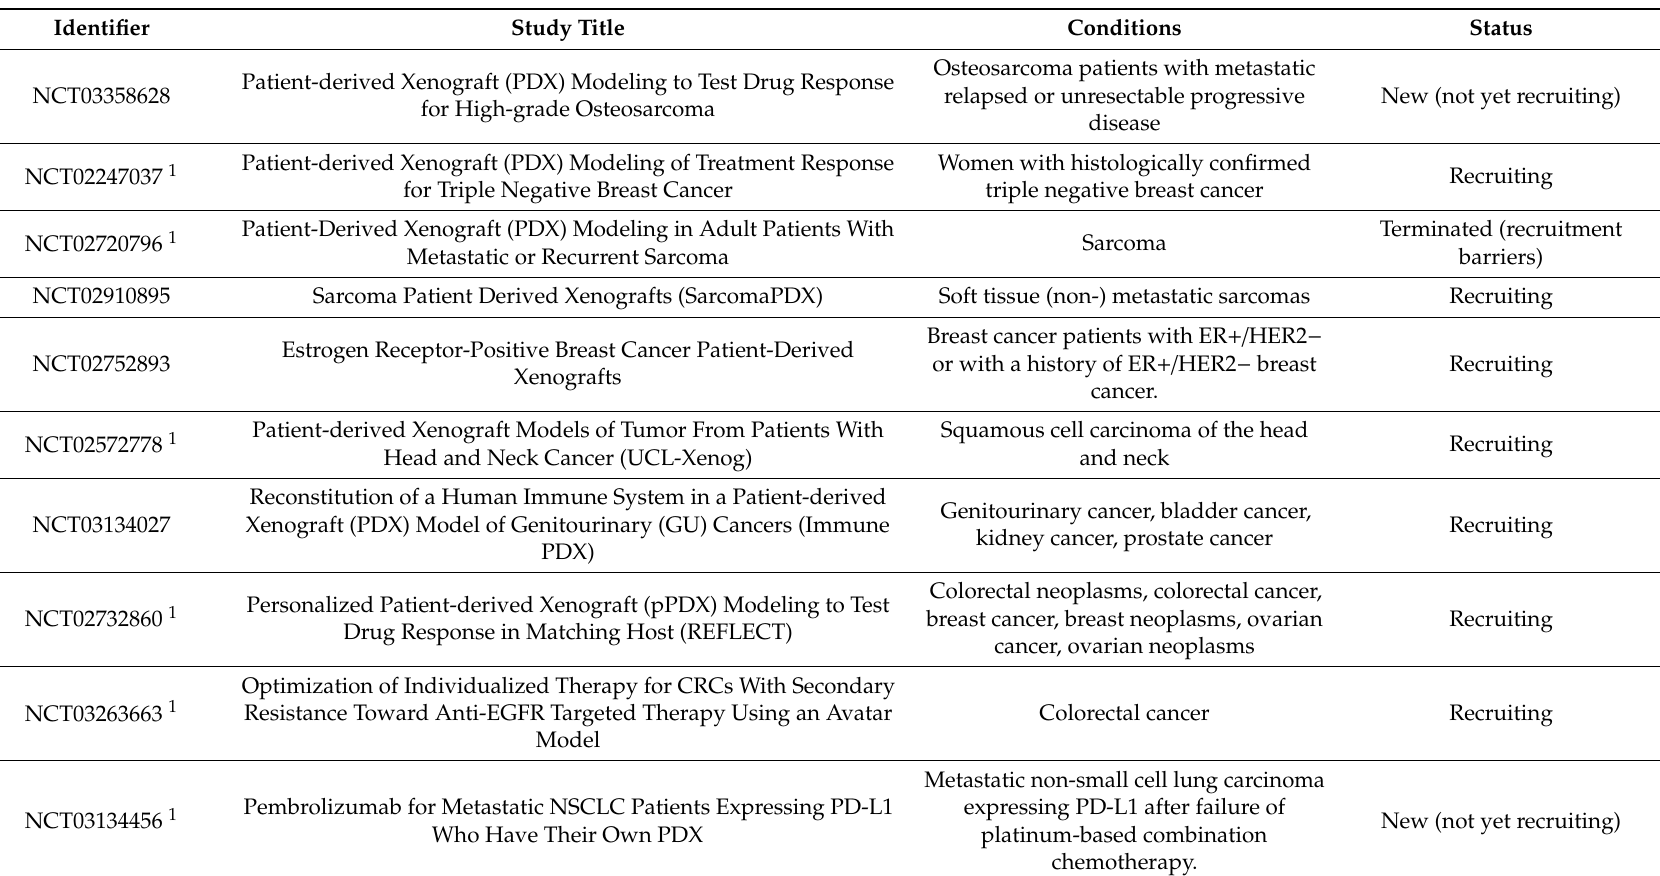
Table 1. Clinical trials involving PDX